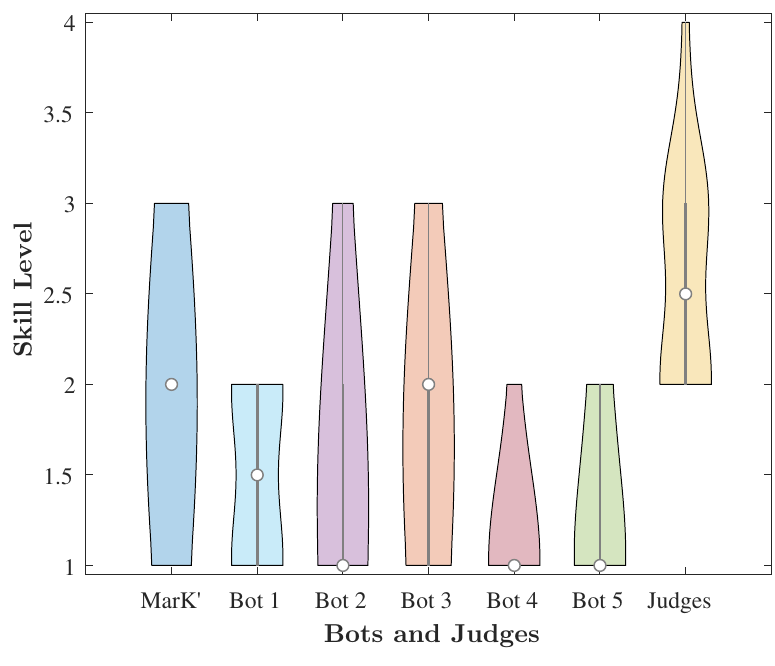
Figure 9. Evaluation of HRLB^2 violin